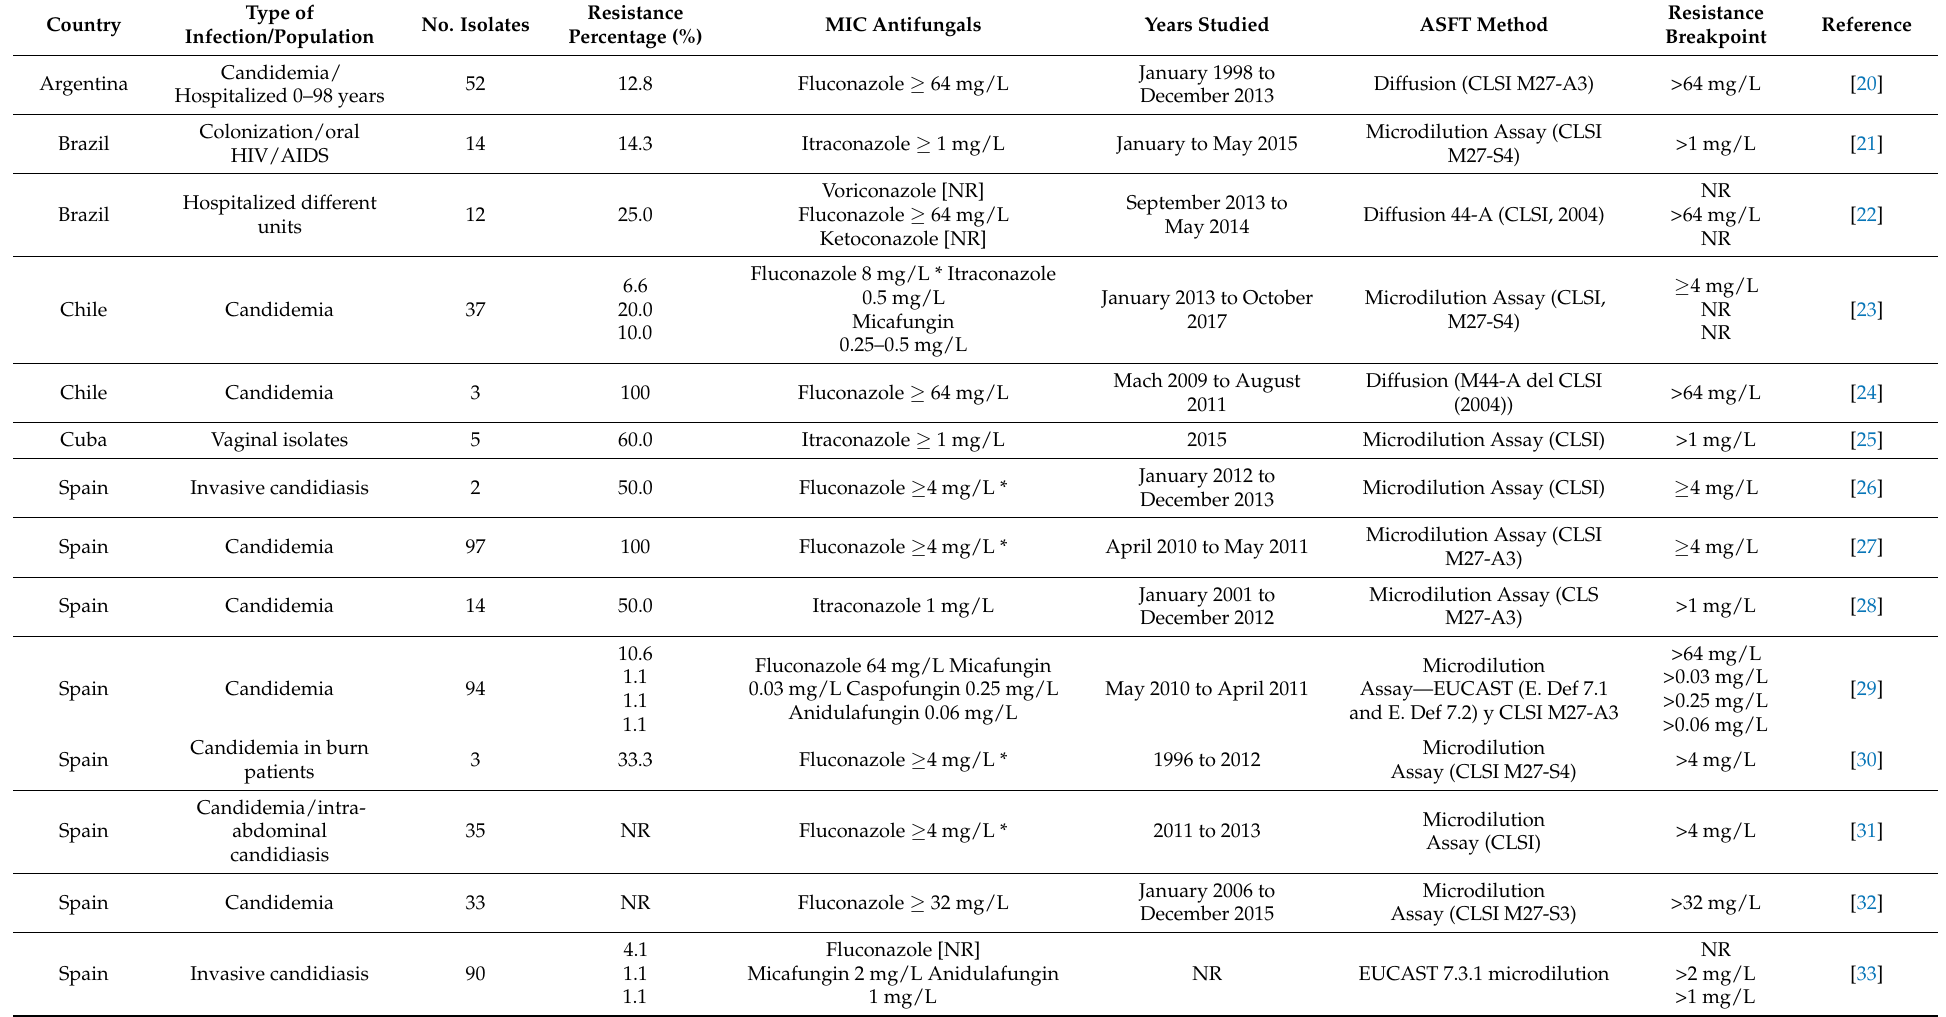
Table 1. Antifungal resistance in clinical isolates of C. glabrata sensu stricto from Ibero-American